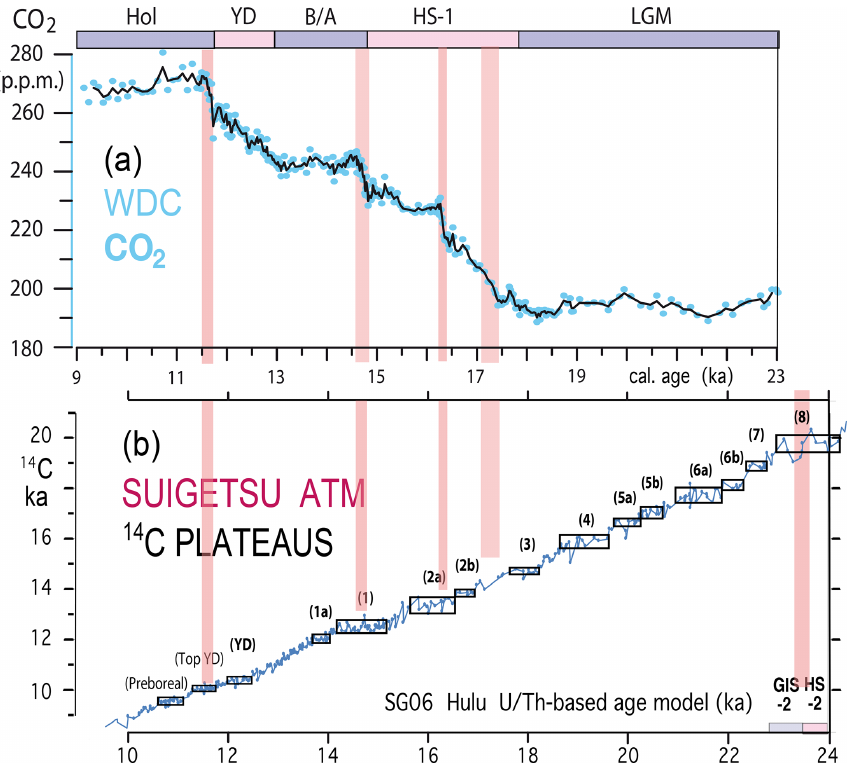
Figure 6. (a) Four sudden steps (pink bars) in the deglacial atmospheric CO 2 rise at West Antarctic Ice Sheet Divide ice core (WDC) reflect events of fast ocean degassing, that may have contributed to the origin of deglacial 14 C plateaus. Age control based on ice cores (Marcott et al., 2014). (b) The steps are compared to suite of atmospheric 14 C plateaus dated by Hulu U / Th-based model ages (Bronk Ramsey et al., 2012). Hol stands for Holocene, YD stands for Younger Dryas, B/A stands for Bølling-Allerød, HS stands for Heinrich stadials 1 and 2, LGM stands for Last Glacial Maximum, and GIS-2 stands for Greenland interstadial